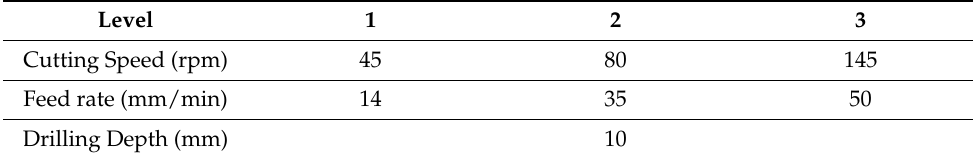
Table 6. Cutting parameters of